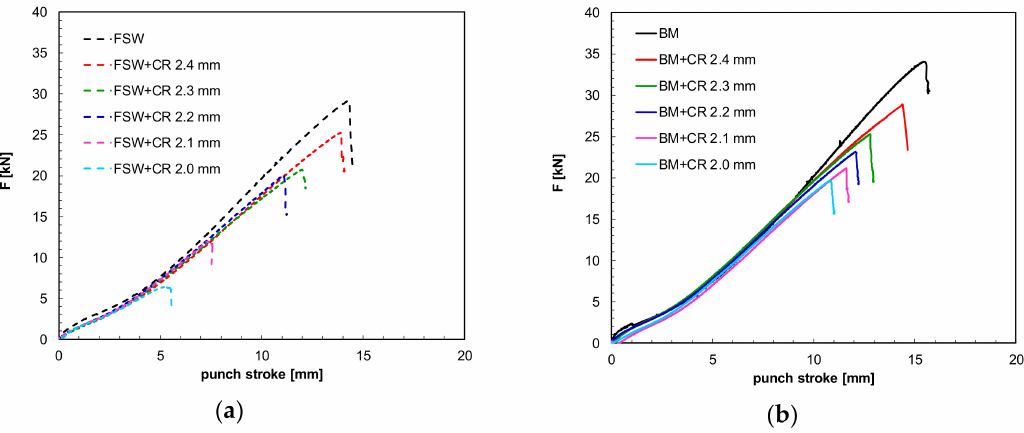
Figure 6. Punch load vs. stroke curves obtained by hemispherical punch test performed on: ( a ) FSWed+CRed and ( b ) BM+CRed